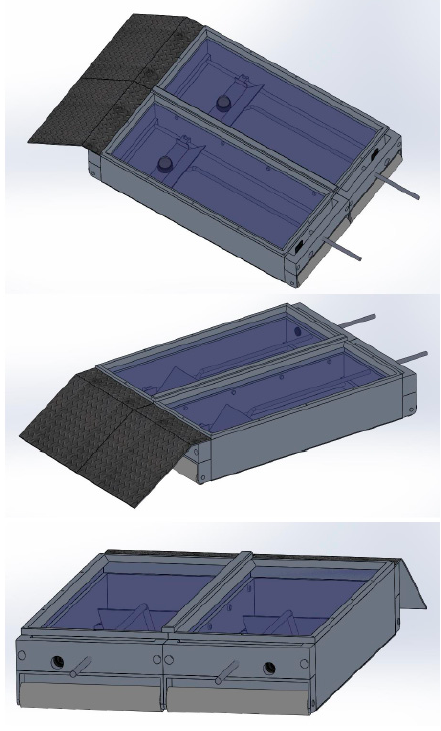
Figure 7. Current MCSD after adaptions of the three previous prototypes. Table 2. Validation of the claw lesion scores obtained from the MCSD with soiled claws compared with the claw lesion scores obtained from the Feet First © chute (“sow chute”, Zinpro Corporation) with cleaned claws as the gold standard. Values are least square means (LSmeans) (mm). Hind Claw Claw Lesion Type Claw Digit